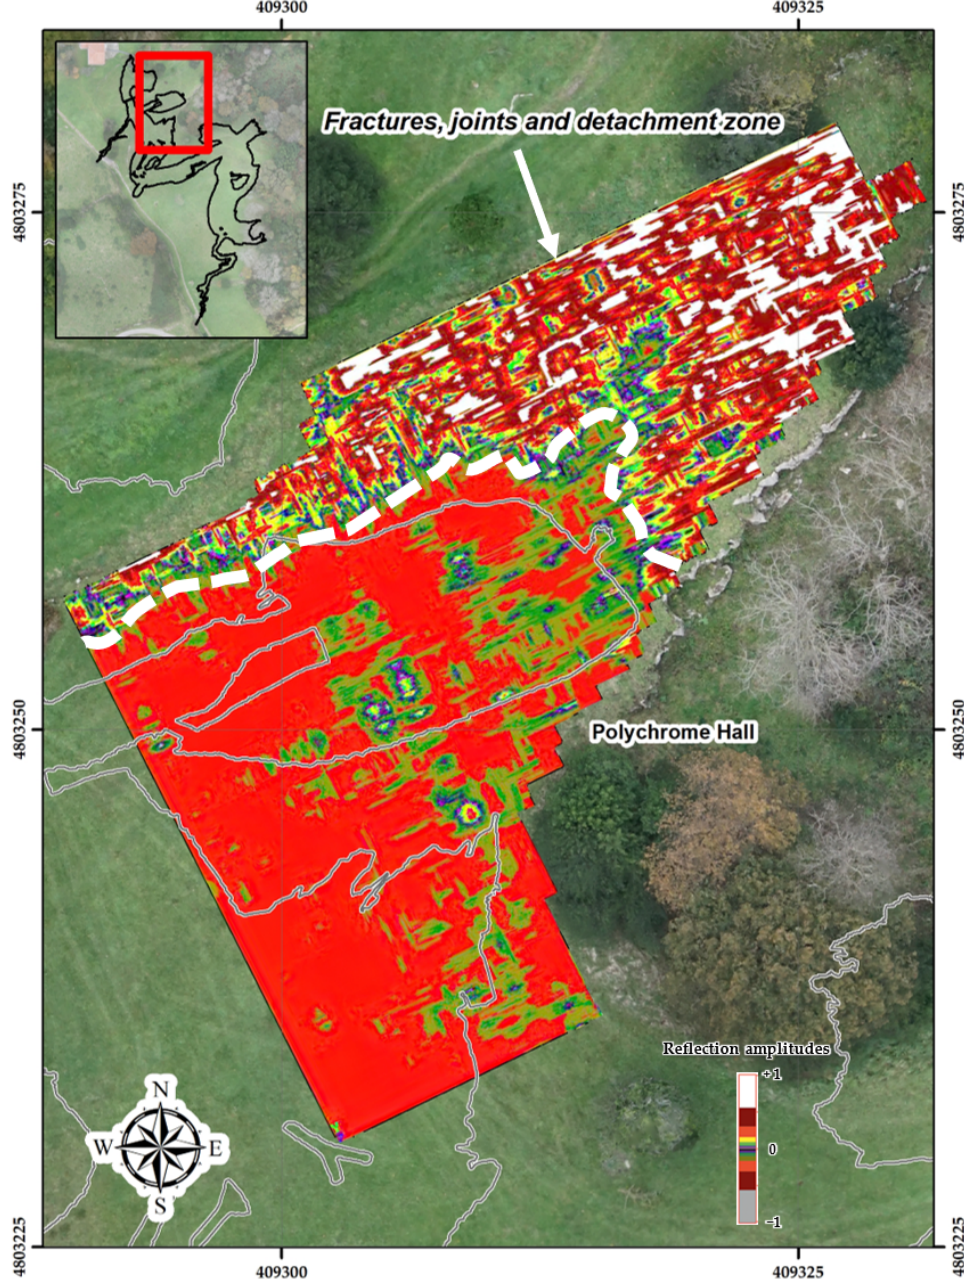
Figure 14. Amplitude slice, 2.20 m depth with the 400 MHz antenna, showing the fracture, joint, and detachment zone (marked in white) on the vertical projection of the Polychrome Hall. This zone of discontinuities is located only to the north and east of the Polychrome Hall projection.